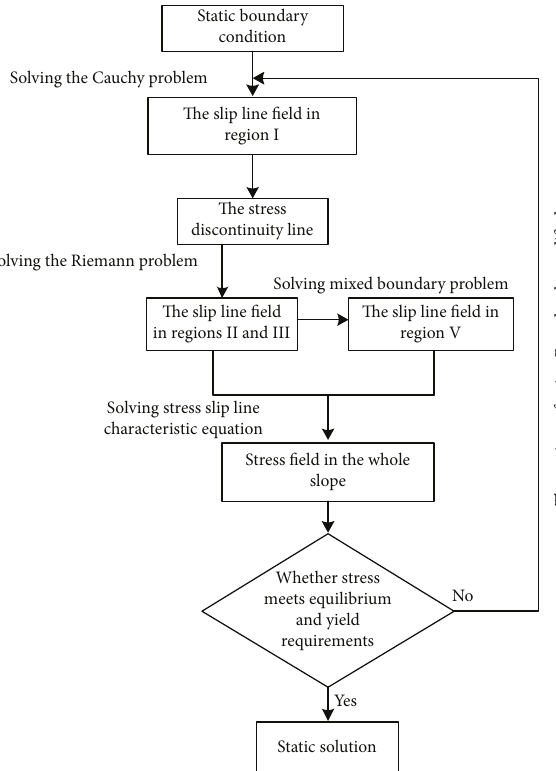
Figure 9: Flow chart of static